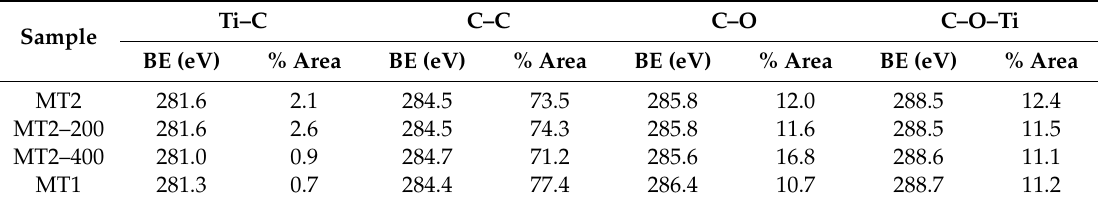
Figure 9. XPS spectra in the regions of: ( A ) Ti2p, ( B ) O1s (both regions for the material (MT2) sample taken as representative) and ( C ) C1s (for all the samples). Table 2. Binding energy (eV) and relative area contribution corresponding to di ff erent C species obtained from the fitted spectra in the C 1s